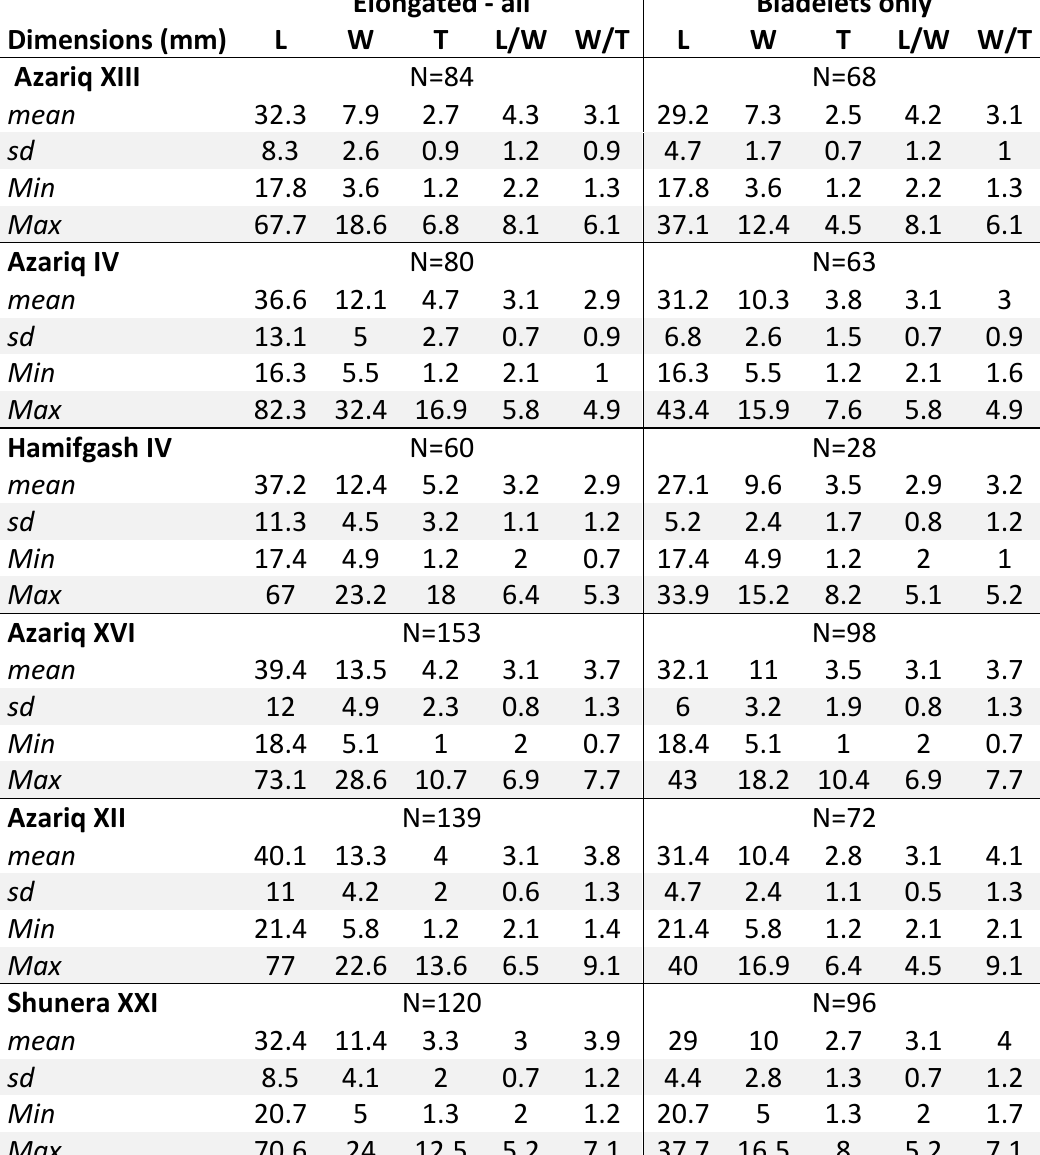
Table 6 - Main statistics for elongated blanks. Abbreviations: L - Length, W - Width, T - Thickness, sd - standard